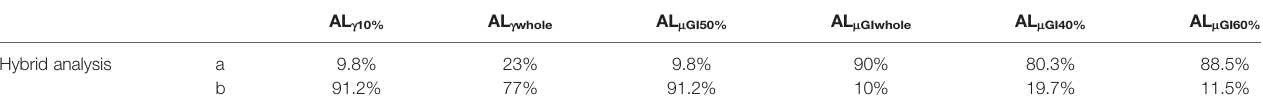
TABLE 3 | The comparison of the hybrid analysis among the evaluation parameters (i.e., AL g 10% , AL g whole , AL m GI50% , AL m GIwhole , AL m GI40% , AL m GI60%